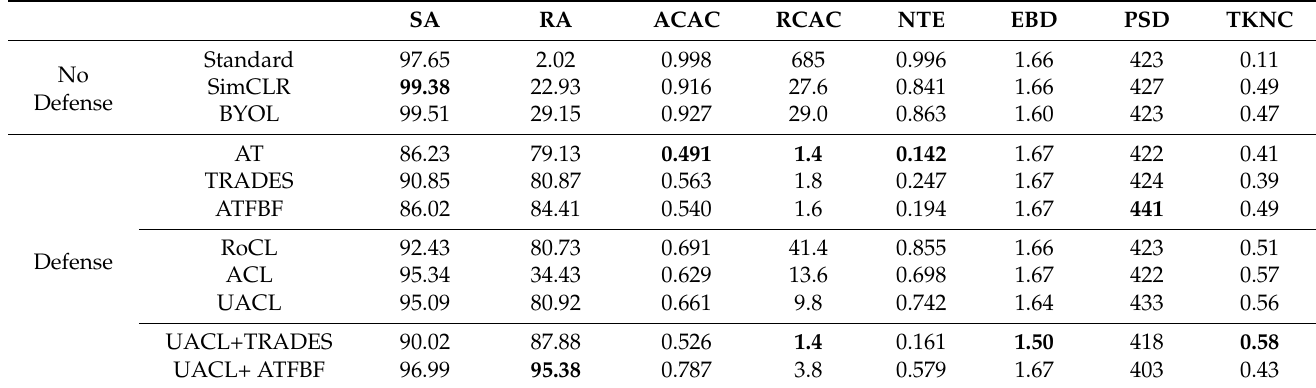
Table 13. Comprehensive evaluation of models (ResNet18) with no-defense or defense methods against PGD attacks (attack strength is 8/255 in L ∞ norm) in MSTAR dataset.